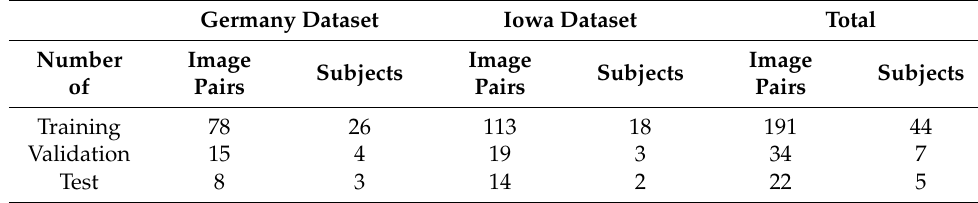
Table 2. Training dataset for segmentation